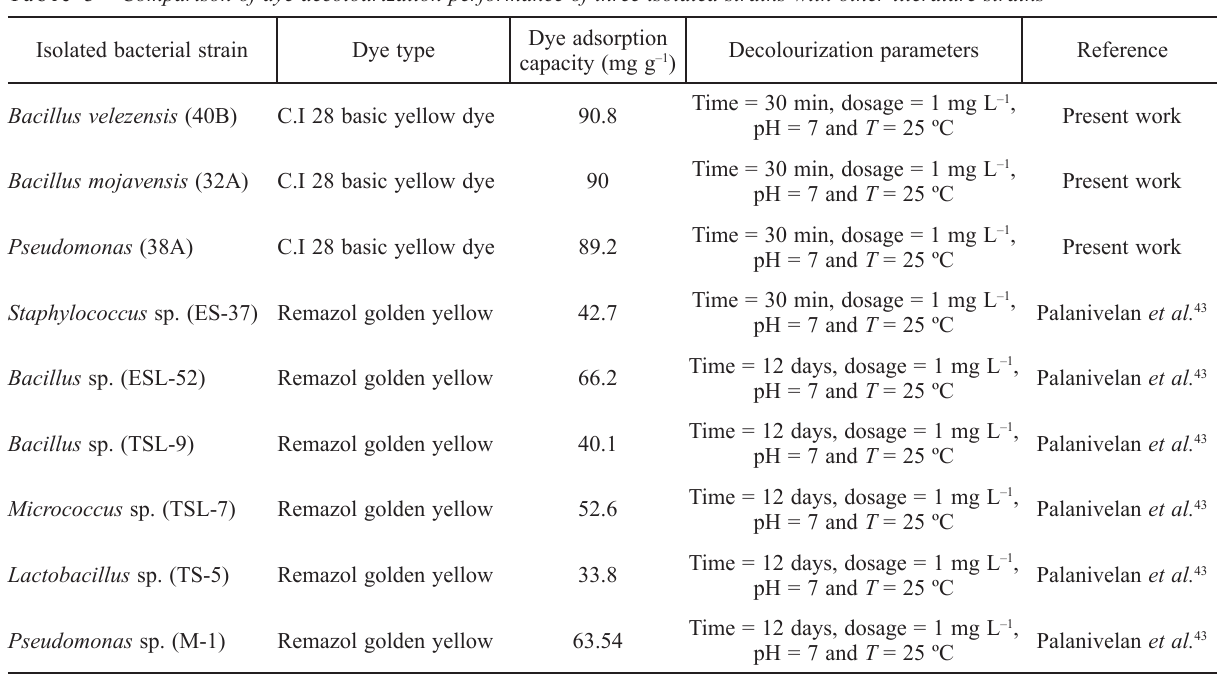
Table 3 – Comparison of dye decolourization performance of three isolated strains with other literature strains Isolated bacterial strain